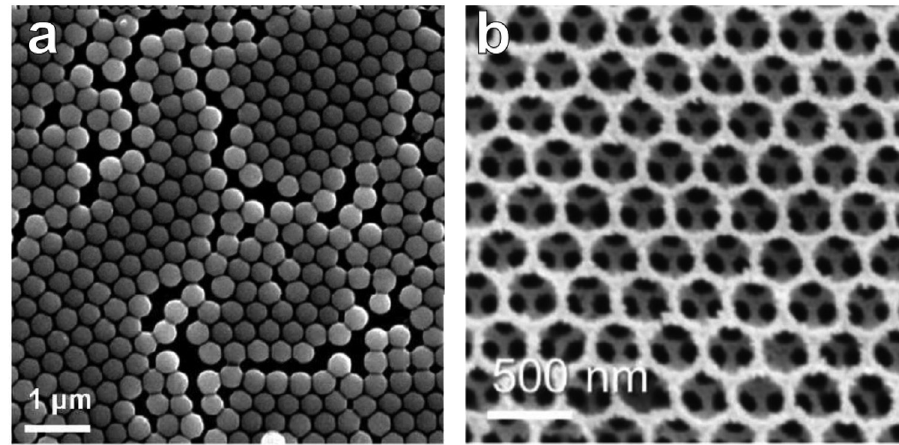
Figure 4: ( a ) Monolayer of CuFeO 2 - shelled silica microspheres assembled on FTO. ( Reprinted with permission from ref. [ 144 ] . Copyright © 2017, American Chemical Society ) . ( b ) Top view of inverse opal CuFeO 2 on FTO. ( Reprinted with permission from ref. [ 143 ] . Copyright © 2019, John Wiley and Sons )